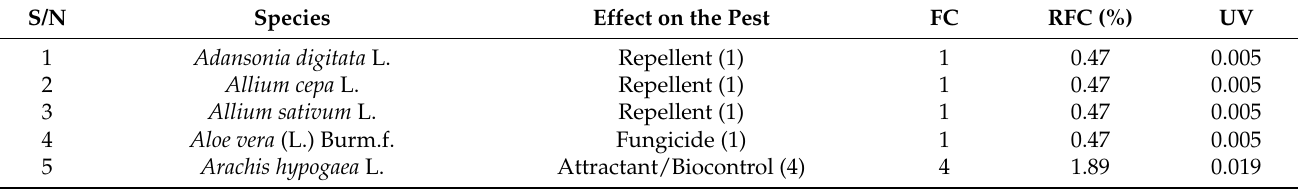
Table 4. Frequency of Citation (FC), % Relative Frequency of Citation (%RFC), and Use Value (UV) of pesticidal plants in the study